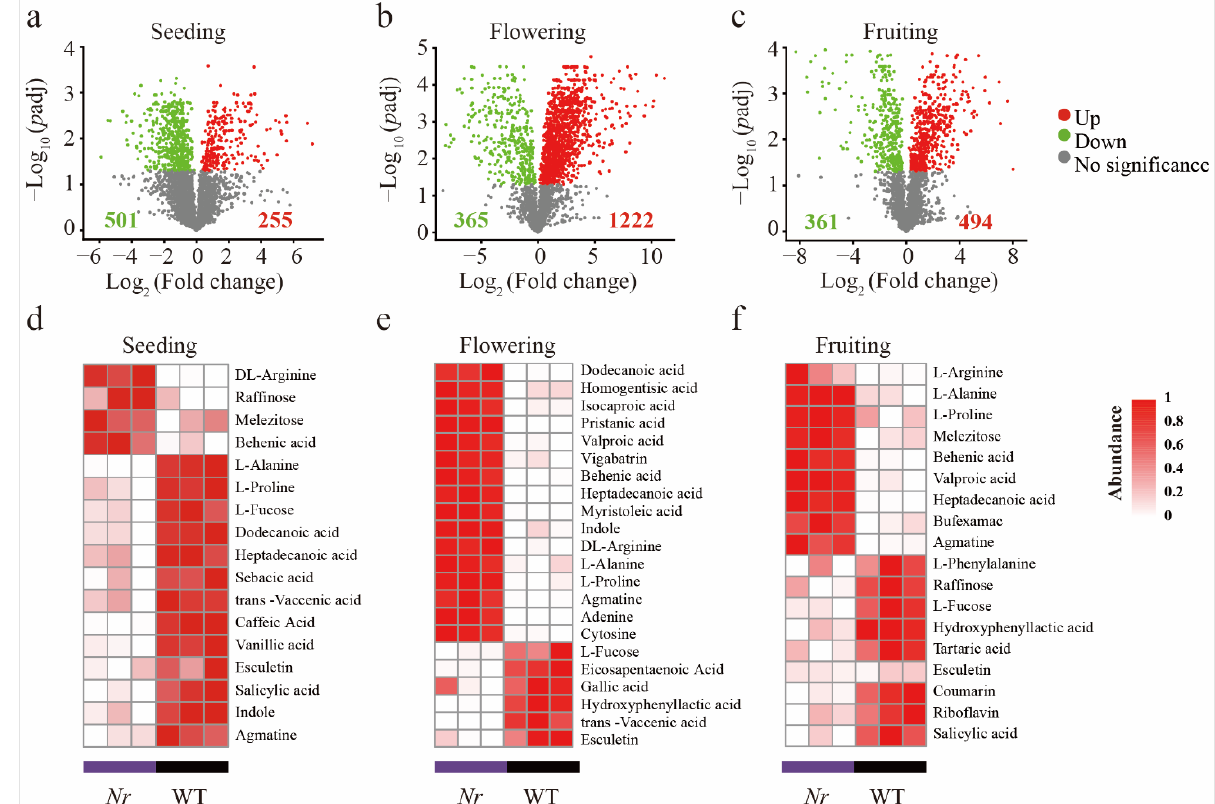
Figure 1. The effect of NR on root exudation profiles of WT and Nr tomato lines. Volcano plots show the statistical significance (y-axis) against fold-change (x-axis) of all ions considered in the root exudates. Red, green, and gray symbols indicate significantly increased, decreased, and un-related ions in abundance ( p -adjusted < 0.05) at the seedling ( a ), flowering ( b ), and fruiting ( c ) stage, respectively. Heatmap shows the abundance of metabolites in root exudates that are significantly influenced by NR at the seedling ( d ), flowering ( e ), and fruiting ( f ) stage, respectively.